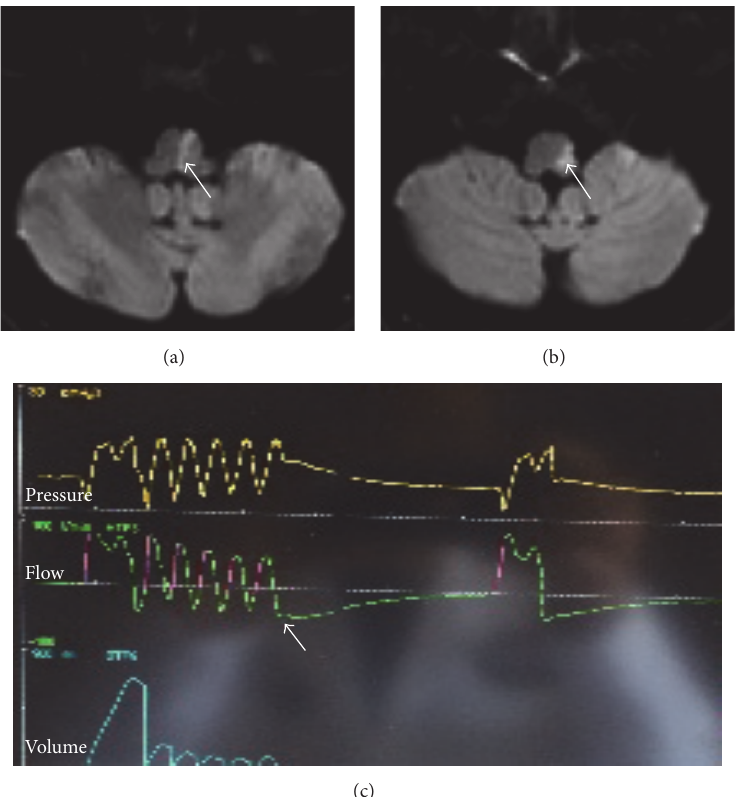
Figure 1: Magnetic resonance imaging of the brain. Diffusion weighted imaging (DWI) showing left medial (a, arrow) and lateral (b, arrow) medullary acute ischemia. (c) Ventilator picture showing cluster breathing pattern (arrow).